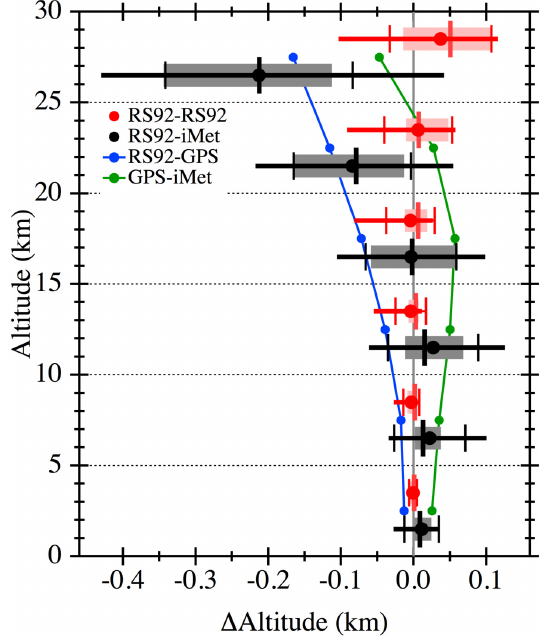
Fig. 18. Statistics of 1 Alt reflect differences in geopotential heights for paired RS92 sondes (red) and for RS92-iMet sondes (black) in 5-km altitude bins. Each of the symbols represents the same statistics of differences described for Fig. 5. Geopotential heights are calculated using P , T , and RH measurements by the radioson- des. The statistically significant negative biases in RS92-iMet 1 Alt above 20km may result from disparities in RS92 and iMet P , T and RH measurements, or from possible differences in the geopotential height algorithms employed by the different sounding systems. Me- dian differences between GPS altitudes and geopotential altitudes for the RS92 sondes (blue markers) and iMet sondes (green mark- ers) in 5-km altitude bins, when combined, are consistent with the mean and median RS92-iMet geopotential height differences in ev- ery altitude